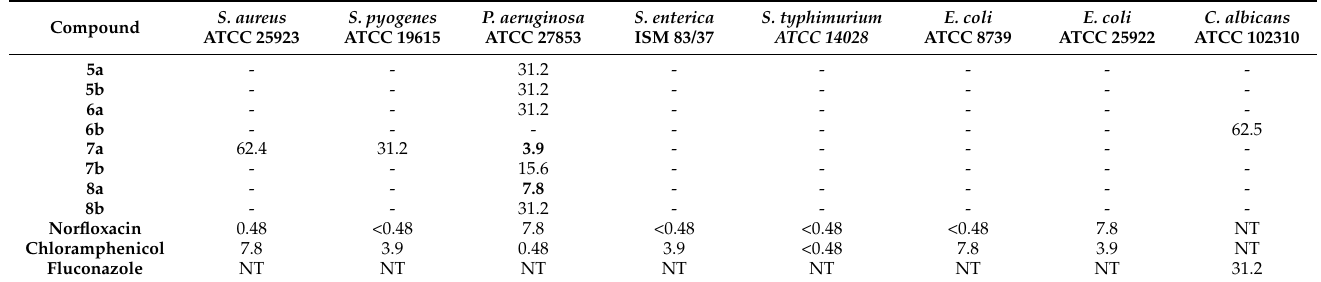
Table 10. Minimum inhibitory concentrations (MIC ( µ g/mL)) of the synthesized compounds.